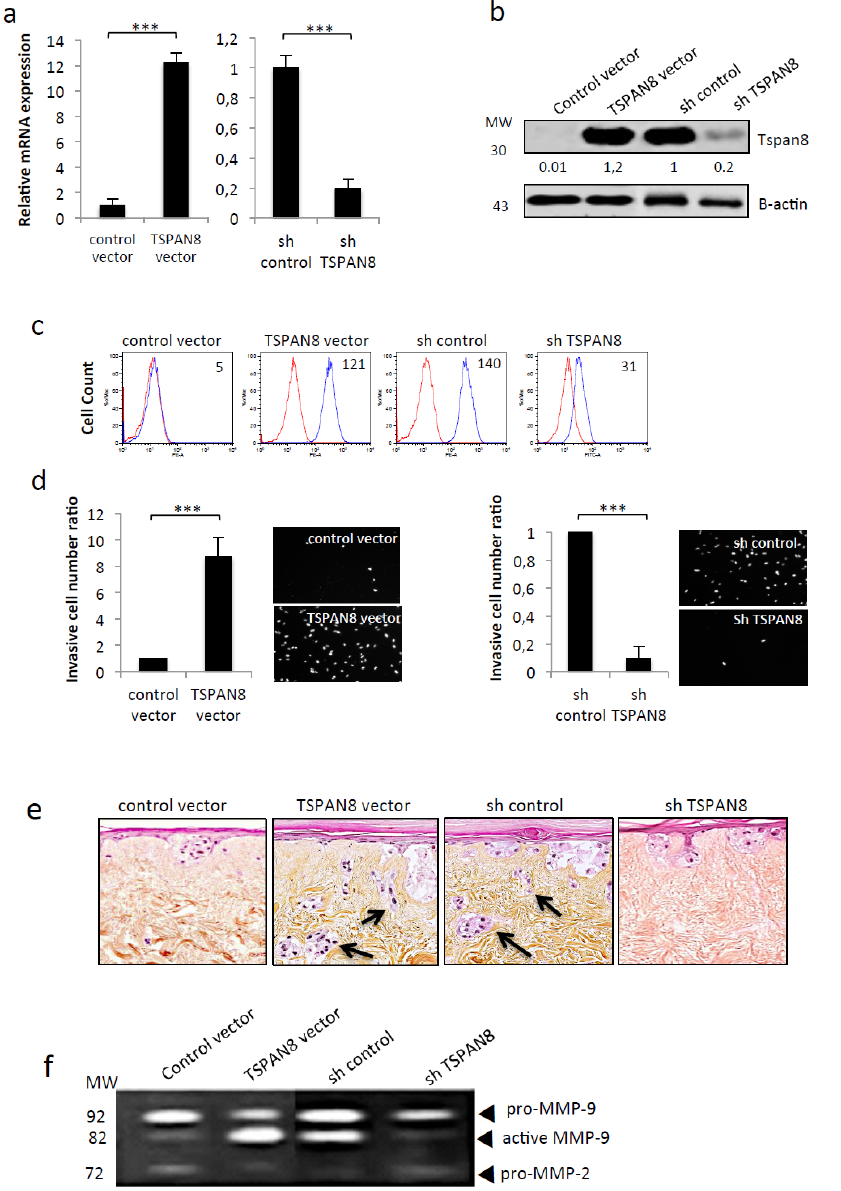
Figure 3. Tspan8 expression in melanoma triggers dermal invasion, concomitantly to MMP-9 activation and collagen IV proteolysis. Non-metastatic stable clones ectopically-expressing Tspan8 (TSPAN8 vector) or not (control vector) Tspan8 (left panel) and metastatic stable clones silenced (shTSPAN8) or not (shcontrol) for Tspan8 (right panel) were subjected to ( a ) QPCR analysis of TSPAN8 transcripts levels ( n = 3; mean ± s.d.). ( b ) Western blot analysis of Tspan8 protein levels with β -Actin as loading control. The band intensities were normalized to actin signal (representative experiment of three), uncropped western blots figures in Figure S1 ( c ) Flow cytometry analysis of cell surface Tspan8 expression (representative experiment of three). ( d ) Matrigel cell invasion assay: invading cells were DAPI-stained (right panel) and quantified (left panel). Data are means ± SD with n = 3 (*** p < 0.001). ( e ) Cells were incorporated into the epidermis of skin reconstructs as described in Materials and Methods. Representative hematoxylin and eosin-stained skin reconstruct were shown. Arrows denote melanoma cells located into the dermis. ( f ) Serum-free conditioned media collected from SR were analyzed by gelatin zymography at 21 days (representative zymogram of 3 independent experiments). Molecular weight (MW) markers are indicated in